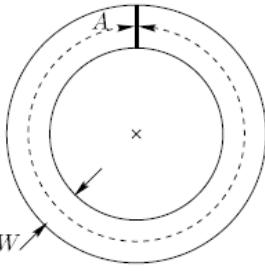
Figure 2. Representation of the circular-tracing task. A is the perimeter (dotted line) of the circle’s centre (x) and W stands for the path width (continuous lines). From Accot and Zhai [31].